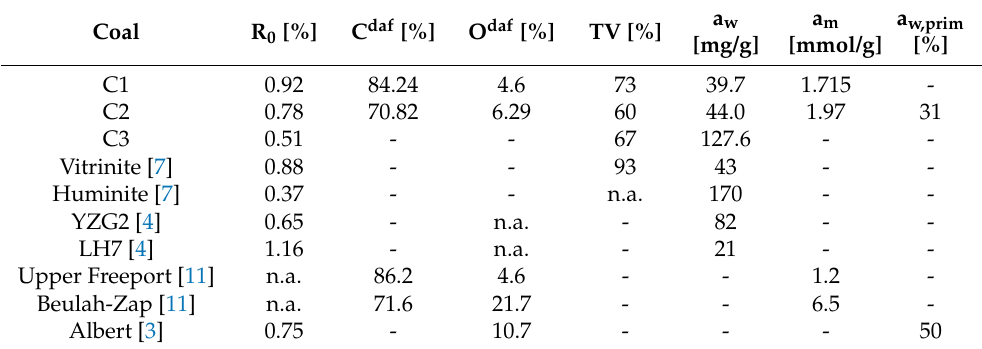
Table 3. Comparison of selected relevant self-reported and literature data.